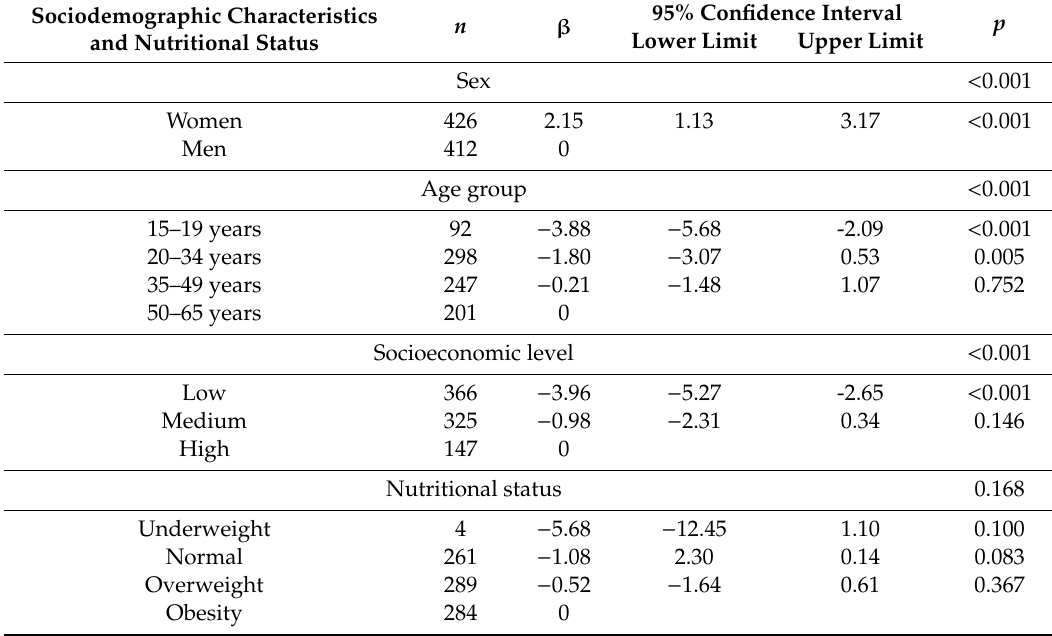
Table 4. Adjusted linear regression model of associations between Alternate Healthy Eating Index 2010 with sociodemographic characteristics and nutritional status in Chilean urban population enrolled in ELANS